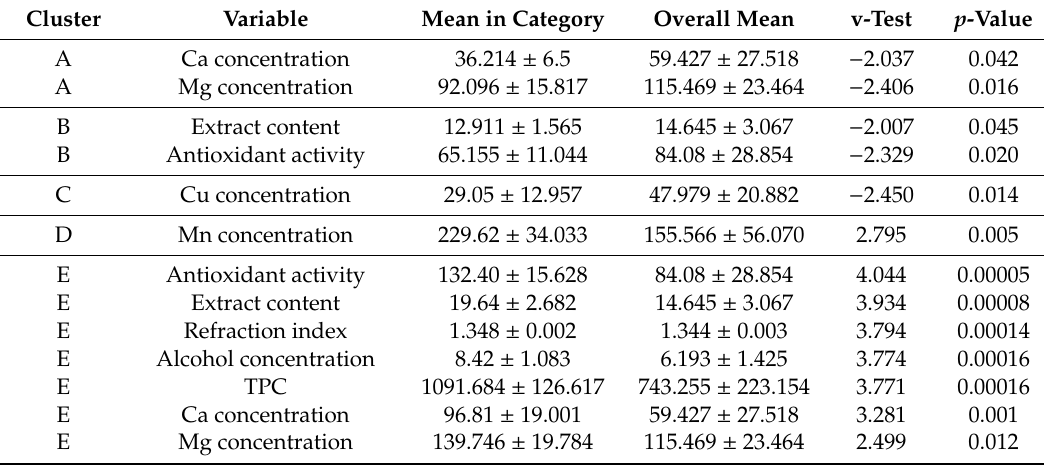
Table 6. Results for the hierarchical clustering on principal components. Description of each cluster by quantitative variables. Only variables that characterize each cluster are shown ( p -value < 0.05). Values of the v-test are sorted from strongest to weakest significance in the construction of the given cluster, i.e., the higher the positive or the lower the negative value is the better / stronger description of the cluster it